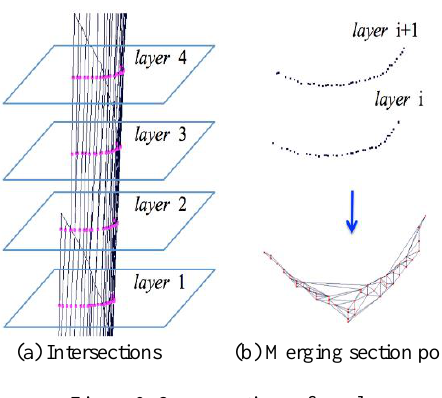
Figure 9. Cross-sections of a pole